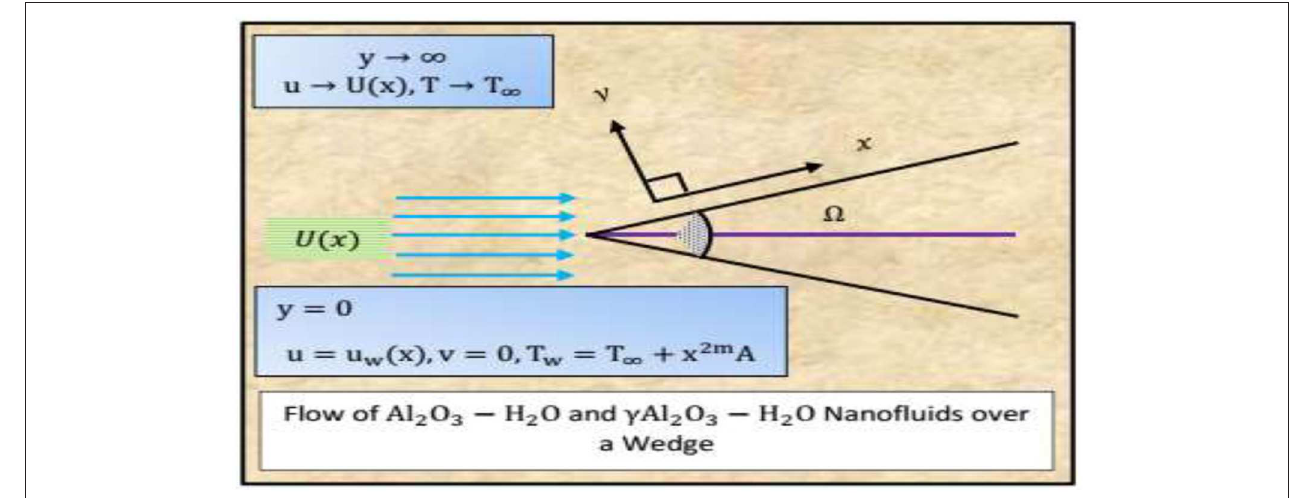
FIGURE 1 | Physical Theme of the